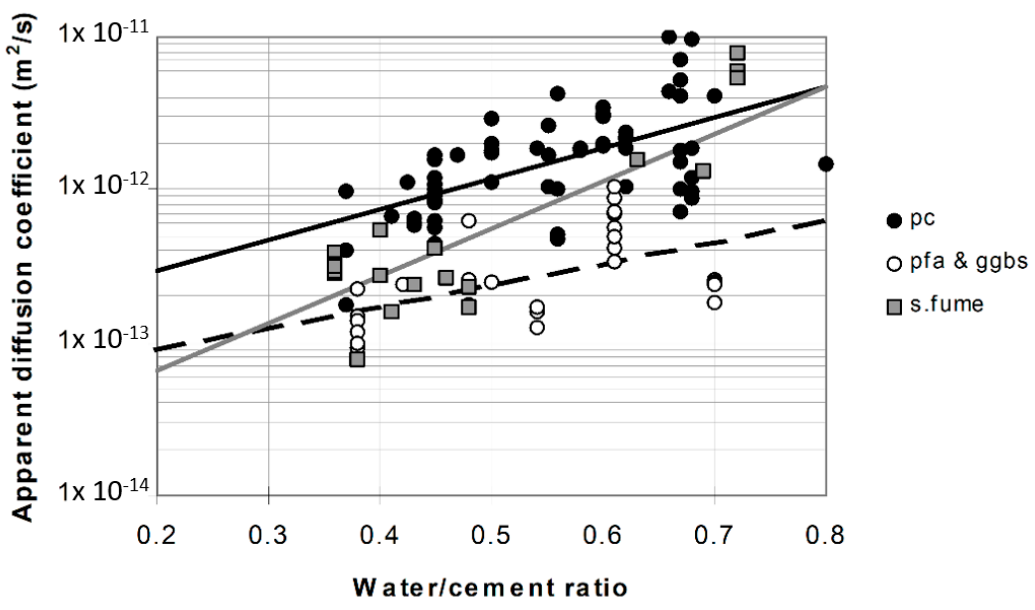
Figure 2. Diffusion coefficient vs. water/cement ratio, presented in Bamforth [8]. Adapted with permission from [8] Copyright 2004, The Concrete Society.